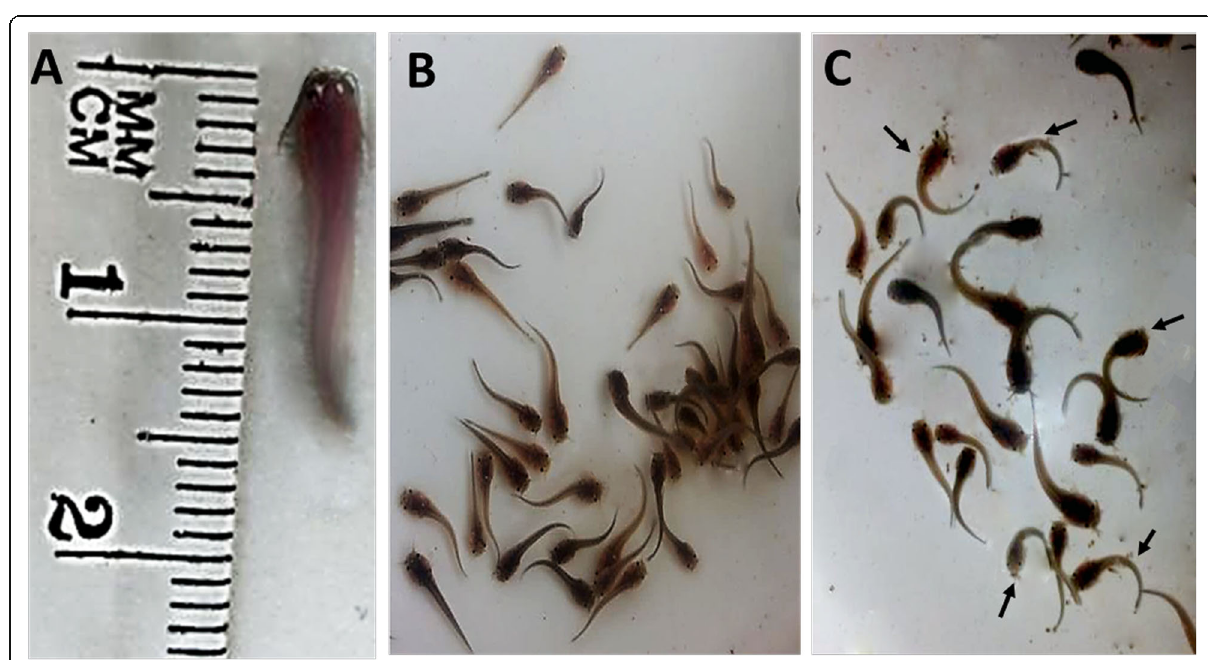
Fig. 1 Behavioral changes of Heteropneustes fossilis after 7 days. a measurement of the size, b control group, and c pesticide, Envoy 50 SC (0.015 ppm)-treated fish. Arrows are showing more bent structures and abnormal swimming